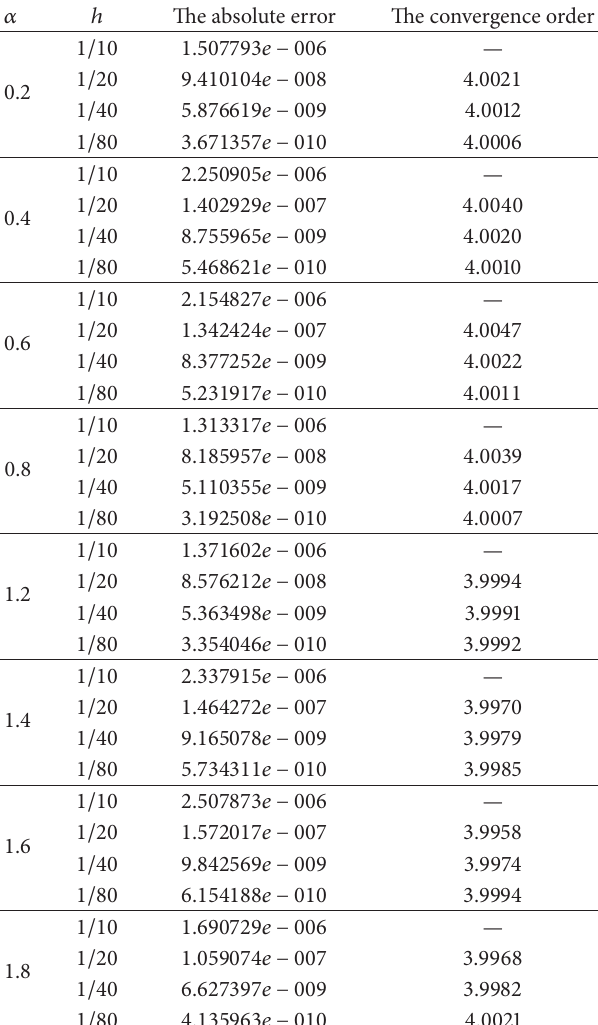
Table 2: The numerical results of Example 7 by difference Scheme (17). 𝛼 The absolute error The convergence The convergence order